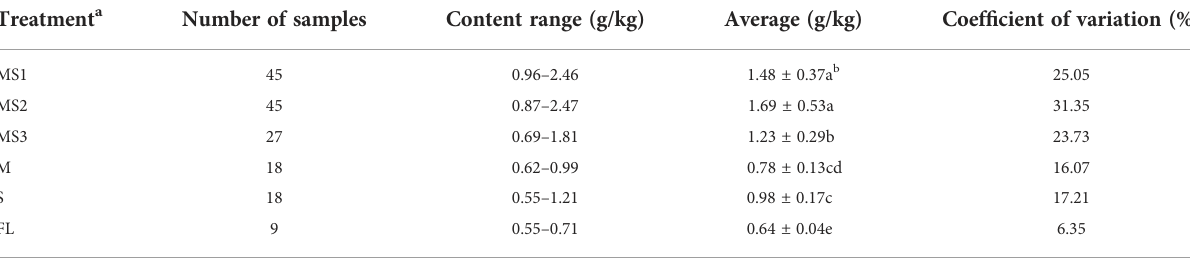
TABLE 3 Total nitrogen content under different planting arrangements of maize and soybean in 2018 – 2020. Treatment